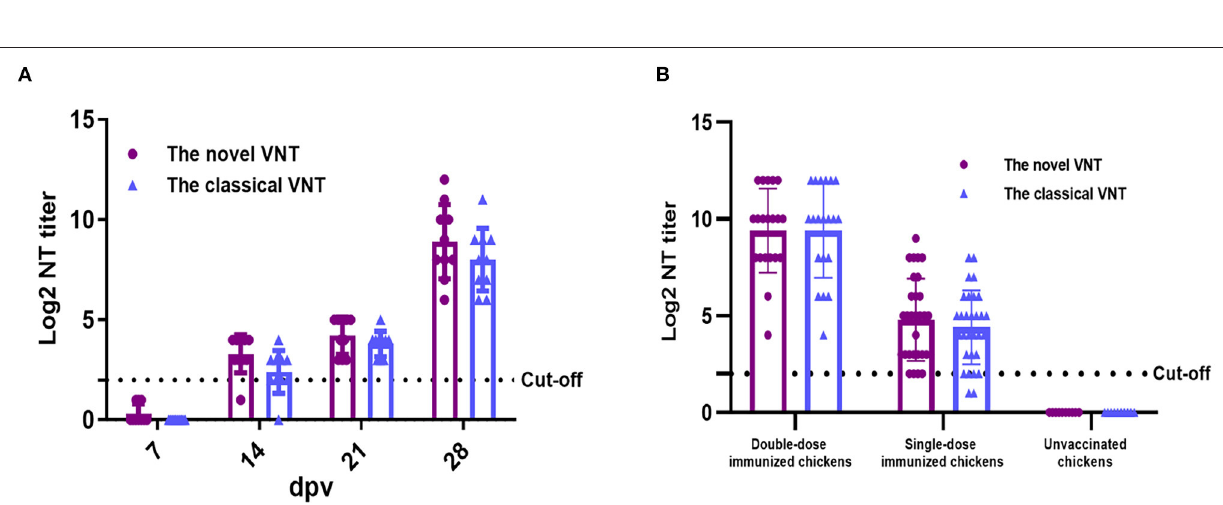
FIGURE 4 | The novel VNT for detection of sera from chickens vaccinated with the inactivated FAdV-4 vaccine. (A) The neutralizing antibodies of sera from the experimentally vaccinated chickens could be efficiently detected at 14, 21, and 28 d post-vaccination (dpv). (B) The neutralizing antibodies of sera from the clinically vaccinated chickens could be efficiently detected at 21